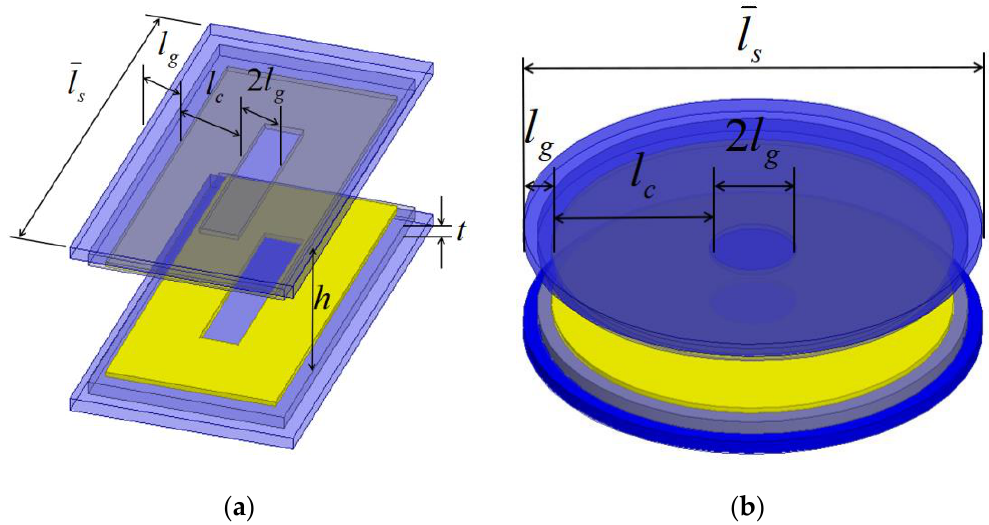
Figure 2. Trimetric view of coupler with single coil: ( a ) Square-shaped wireless coupler; ( b ) Circular wireless coupler.